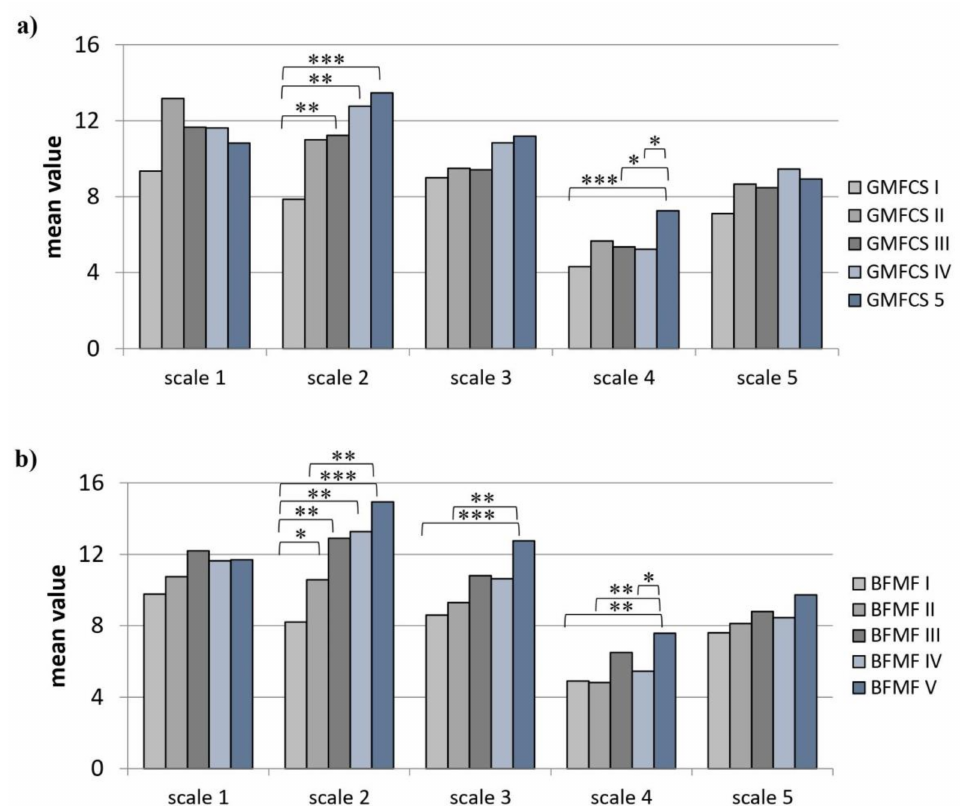
Figure 2. Differences between the five levels of Gross Motor Function Classification System (GMFCS) ( a ) and Bimanual Fine Motor Function (BFMF) ( b ) for the SNAKE scales 1–5. 1. disturbances going to sleep, 2. disturbances remaining asleep, 3. arousal and breathing disorders, 4. daytime sleepiness, 5. daytime behavior disorders. * p < 0.05, ** p < 0.01, *** p <